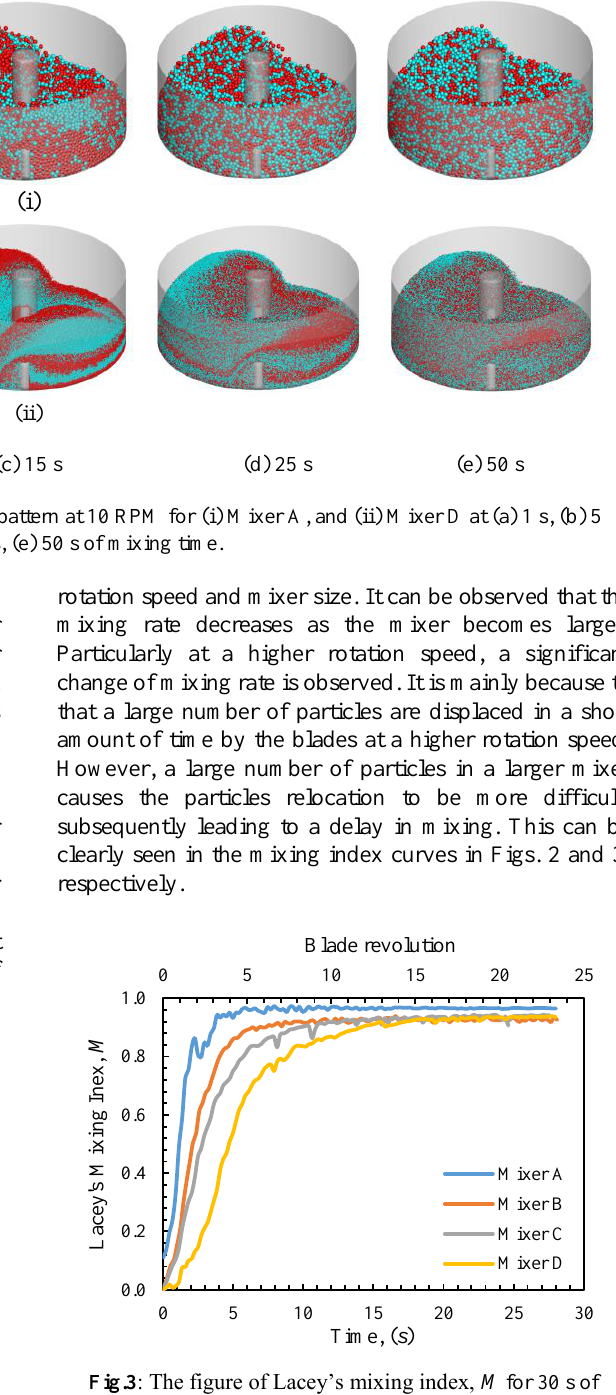
Fig.3 : The figure of Lacey’s mixing index, M for 30 s of mixing at 50 RPM for all mixers.